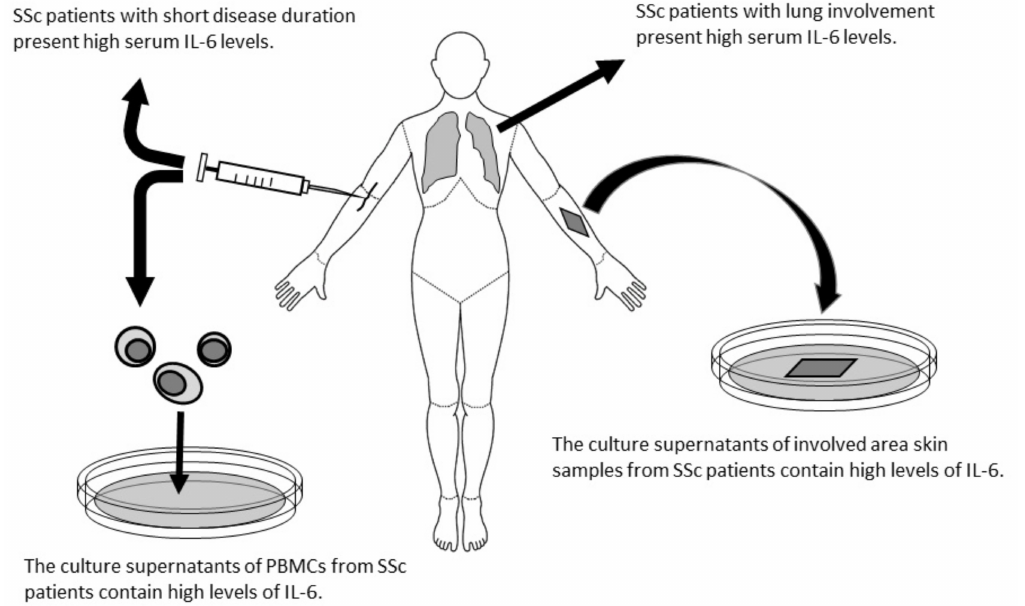
Figure 2. Schematic explanation about the reports that IL-6 is involved in the pathogenesis of SSc [50–54]. IL-6: interleukin-6, PBMCs: peripheral mononuclear